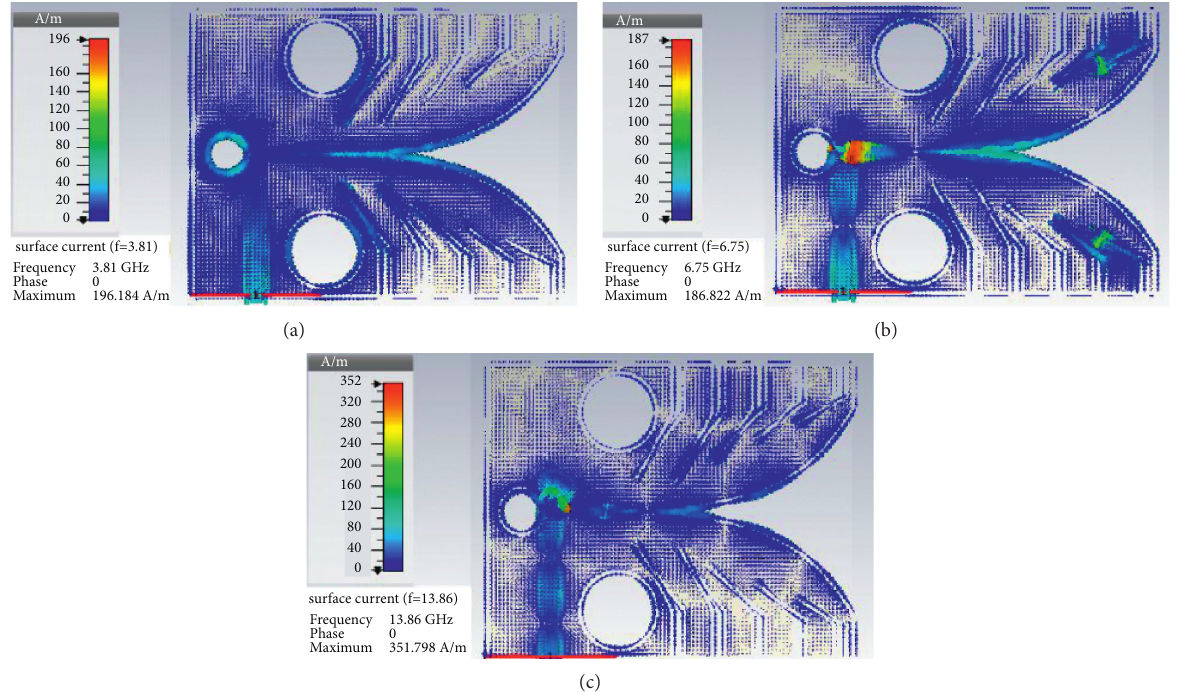
Figure 7: Surface current distribution at (a) 3.81GHz, (b) 6.75GHz, and (c)